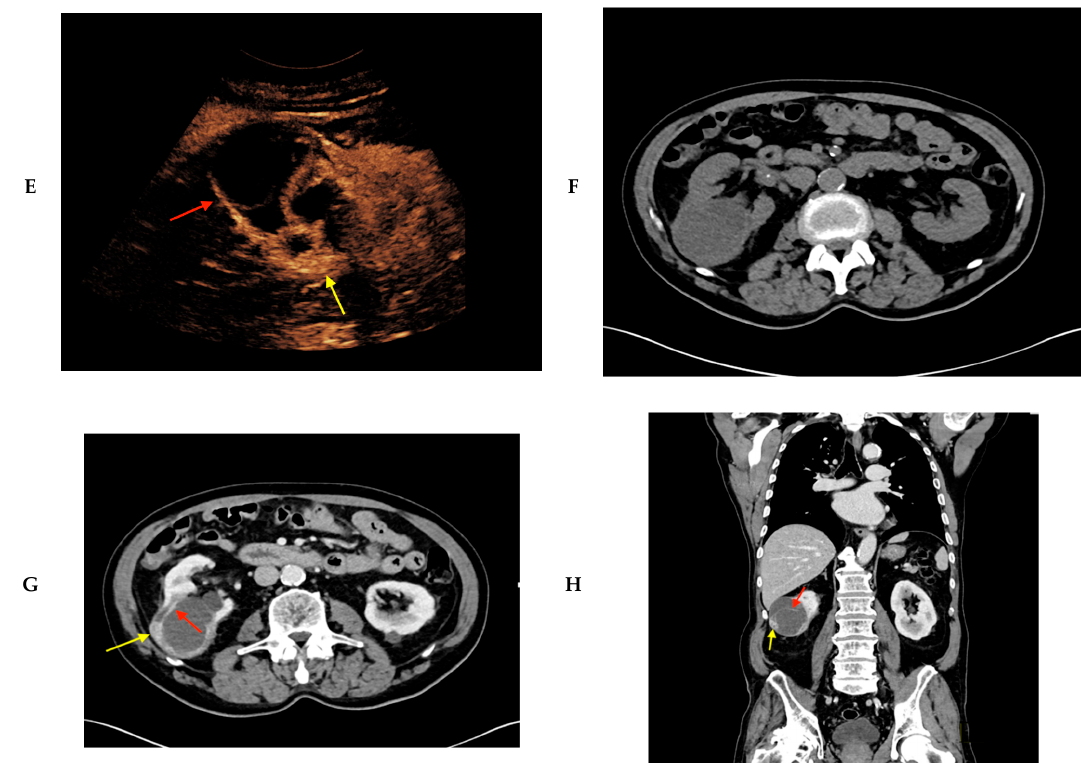
Figure 2. Progression of Bosniak 2F renal cystic lesion to Bosniak 4 category revealed by CEUS in a 67-year-old male patient. Partial nephrectomy and histopathology revealed underlying clear cell renal cell carcinoma. ( A ) Septated cystic renal lesion (red arrow) of the right kidney is registered by native B-mode ultrasound, in keeping with Bosniak Type 2F. ( B ) No hyperperfusion is detected in Color Doppler ultrasound. ( C ) CEUS reveals bright contrast-enhancement of the septa (red arrow). ( D ) Follow-up CEUS after 14 months shows increased contrast-enhancing of the thickened septa (red arrow) of the cystic lesion, thus classified as Bosniak Type 3. ( E ) Besides bright septal contrast-enhancement (red arrow), 28 months follow-up CEUS further reveals additional nodular contrast-enhancement (yellow arrow) of the cystic lesion, hence classified as Bosniak Type 4. ( F ) No calcification is detected in the renal cystic lesion in the corresponding native CT, axial reformation. ( G ) Septal and nodular contrast-enhancement (red and yellow arrow, respectively) of the renal cystic lesion in the corresponding contrast-enhanced CT, venous phase, axial reformation. ( H ) Septal and nodular contrast-enhancement (red and yellow arrow, respectively) of the renal cystic lesion in the corresponding contrast-enhanced CT, coronal reformation, venous